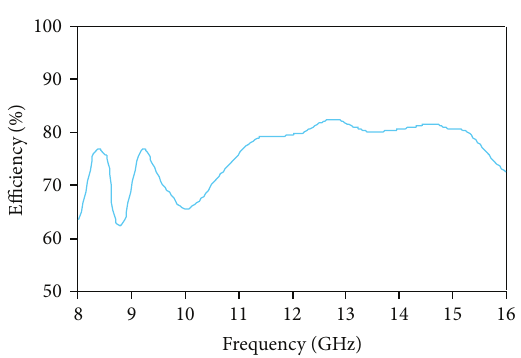
Figure 12: Radiation efficiency of the proposed